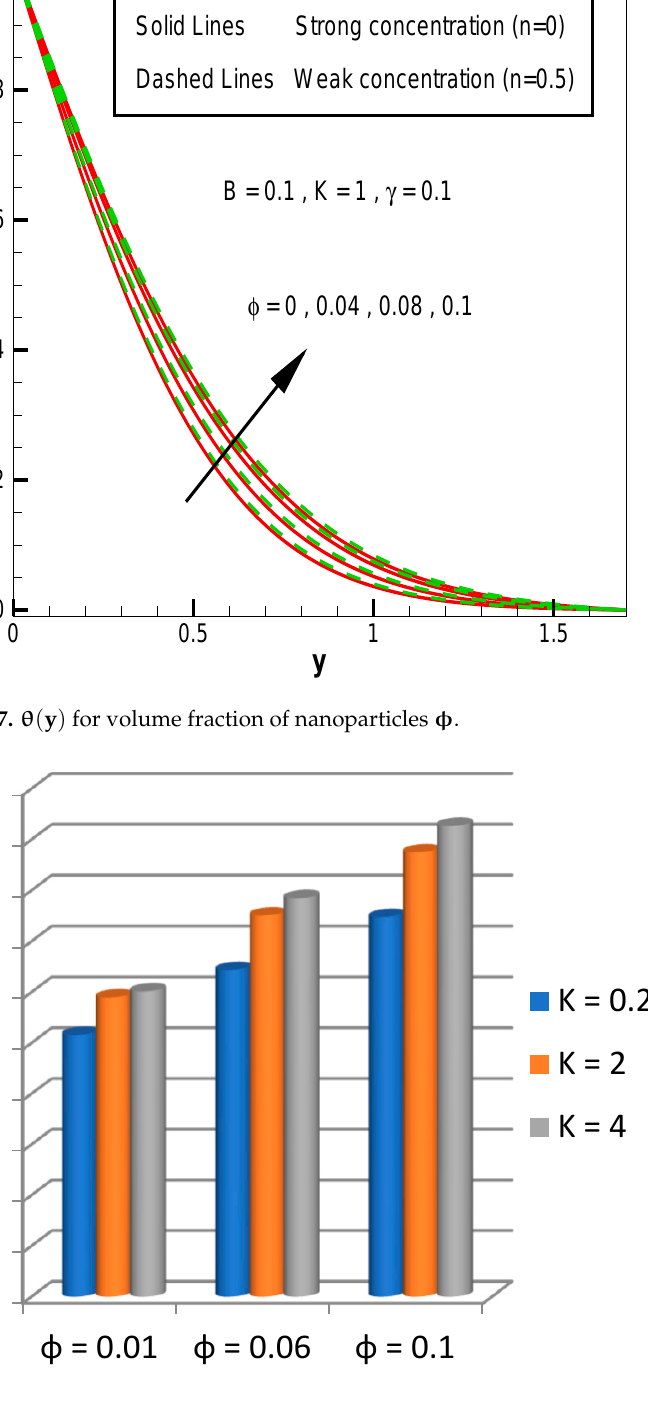
Figure 8. Magnitude of shear stress (cid:4678) 𝟏 against 𝛟 .